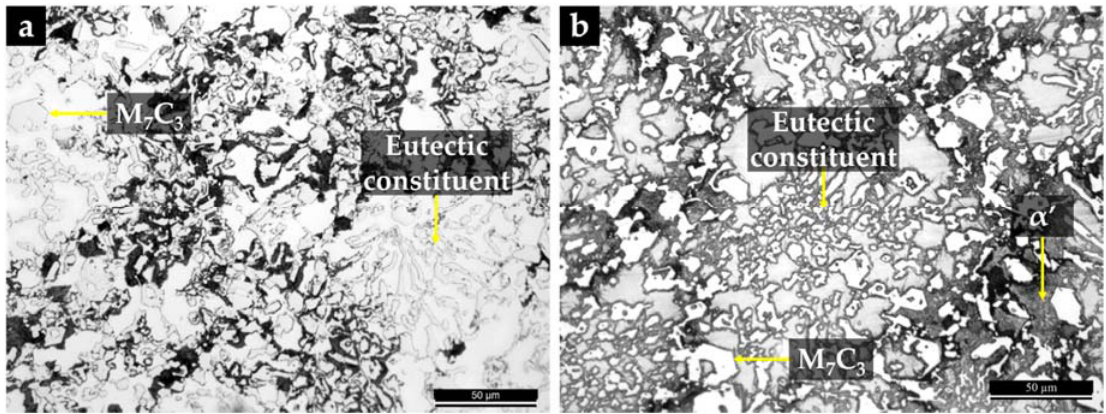
Figure 2. OM images of the high-Cr WCI in the as-cast condition after chemical etching with 2% Nital ( a ) and Beraha- Martensite ( b ).